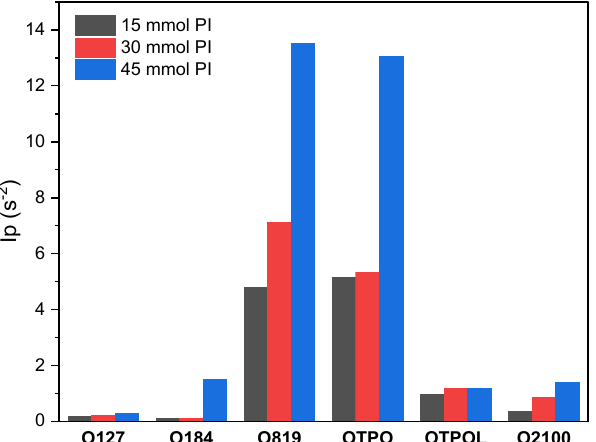
Figure 4. Initiation efficiency (I p ) of the radical photoinitiators used for photo-cotelomerization processes of BA, AA, and ABP with TBM.